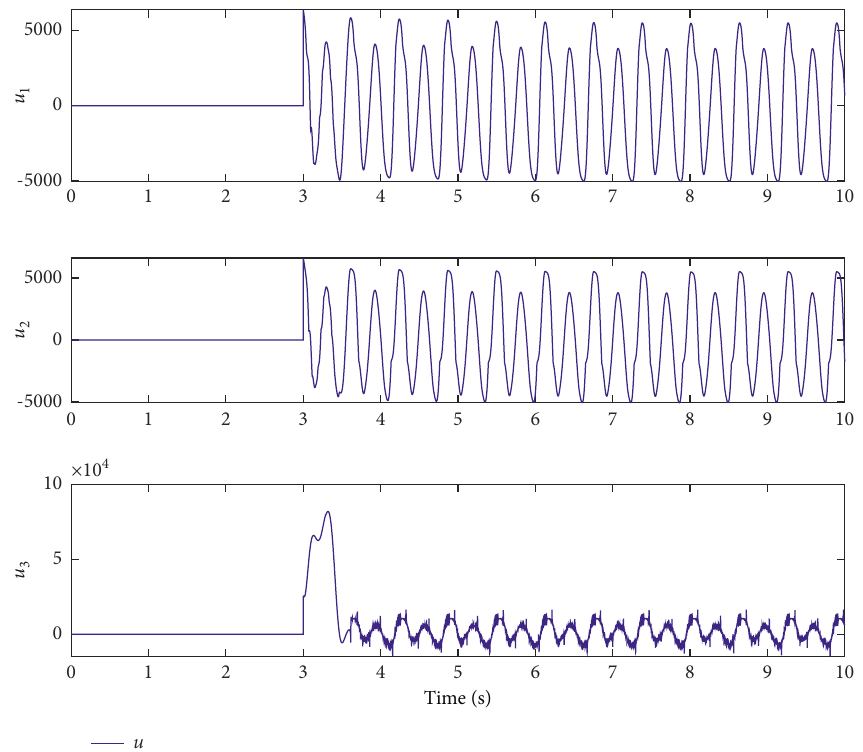
Figure 4: Time responses of the control signals u